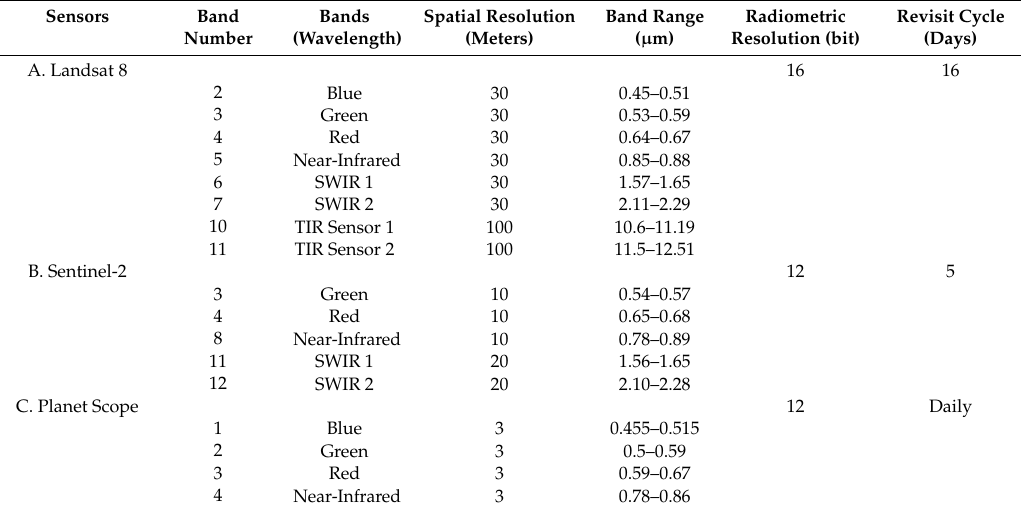
Table 2. Band specifications of satellite sensors used in this